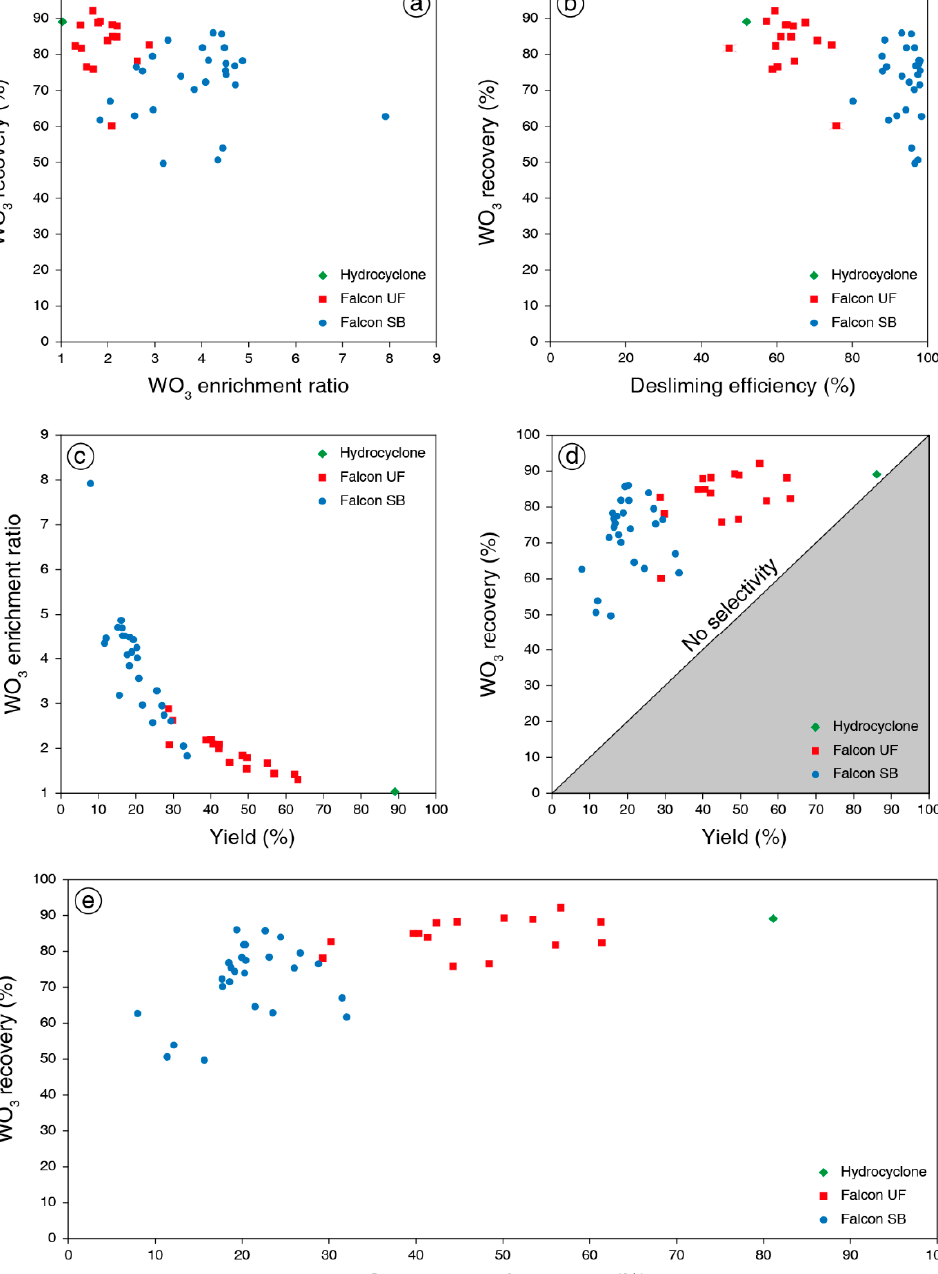
Figure 7. Comparison between a Falcon UF, a Falcon SB, and a classical hydrocyclone in terms of separation performances using DoE results. ( a ) WO 3 recovery versus WO 3 enrichment ratio (grade-recovery curve); ( b ) WO 3 recovery versus desliming efficiency; ( c ) WO 3 enrichment ratio versus yield; ( d ) WO 3 recovery versus yield (selectivity curve); ( e ) WO 3 recovery versus gangue minerals recovery.